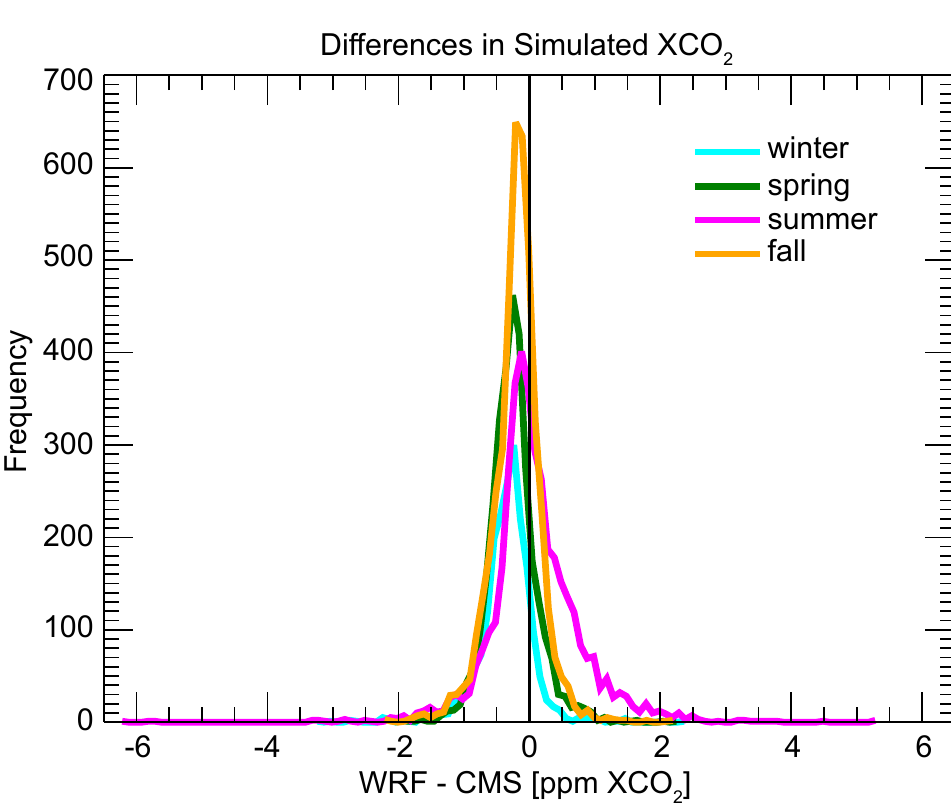
Figure 3. Histograms of model-data residuals between WRF and Atmospheric CO 2 Observations from Space (ACOS) Greenhouse gases Observing SATellite (GOSAT) XCO 2 retrievals coupled at the boundaries to the CMS-Flux simulated mole fractions without mass conservation ( left panel ) and with the newly-developed mass-conserved scheme ( right panel ) for the year 2010.